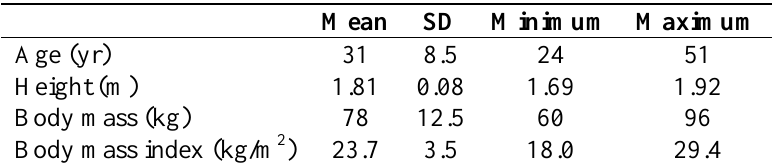
Table 2. Subject characteristics (n = 10).